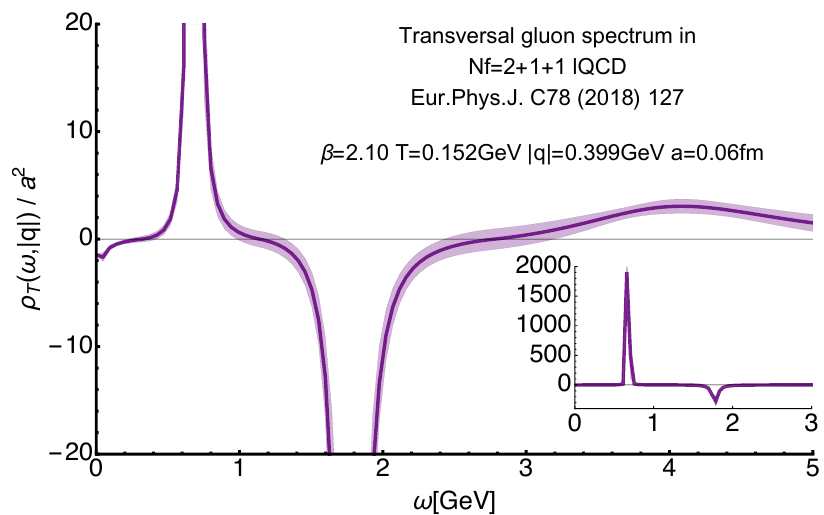
Figure 4: Example of a gluon spectral function in the confined phase T = 152MeV < T extracted from lattice QCD simulations by the tmft collabora- C = 2 + 1 + 1 flavors of quarks. Note that while the higher lying tion including N f negative feature at around 1.75GeV is strongly pronounced, we also find indications for a residual negative contribution at small frequencies. The overshoot into positive values at higher frequencies originally thought of as a Bayesian artifact also emerges in our reconstruction presented below. Error bars include both statistical and sys- tematic errors, for details see [ 6 ]